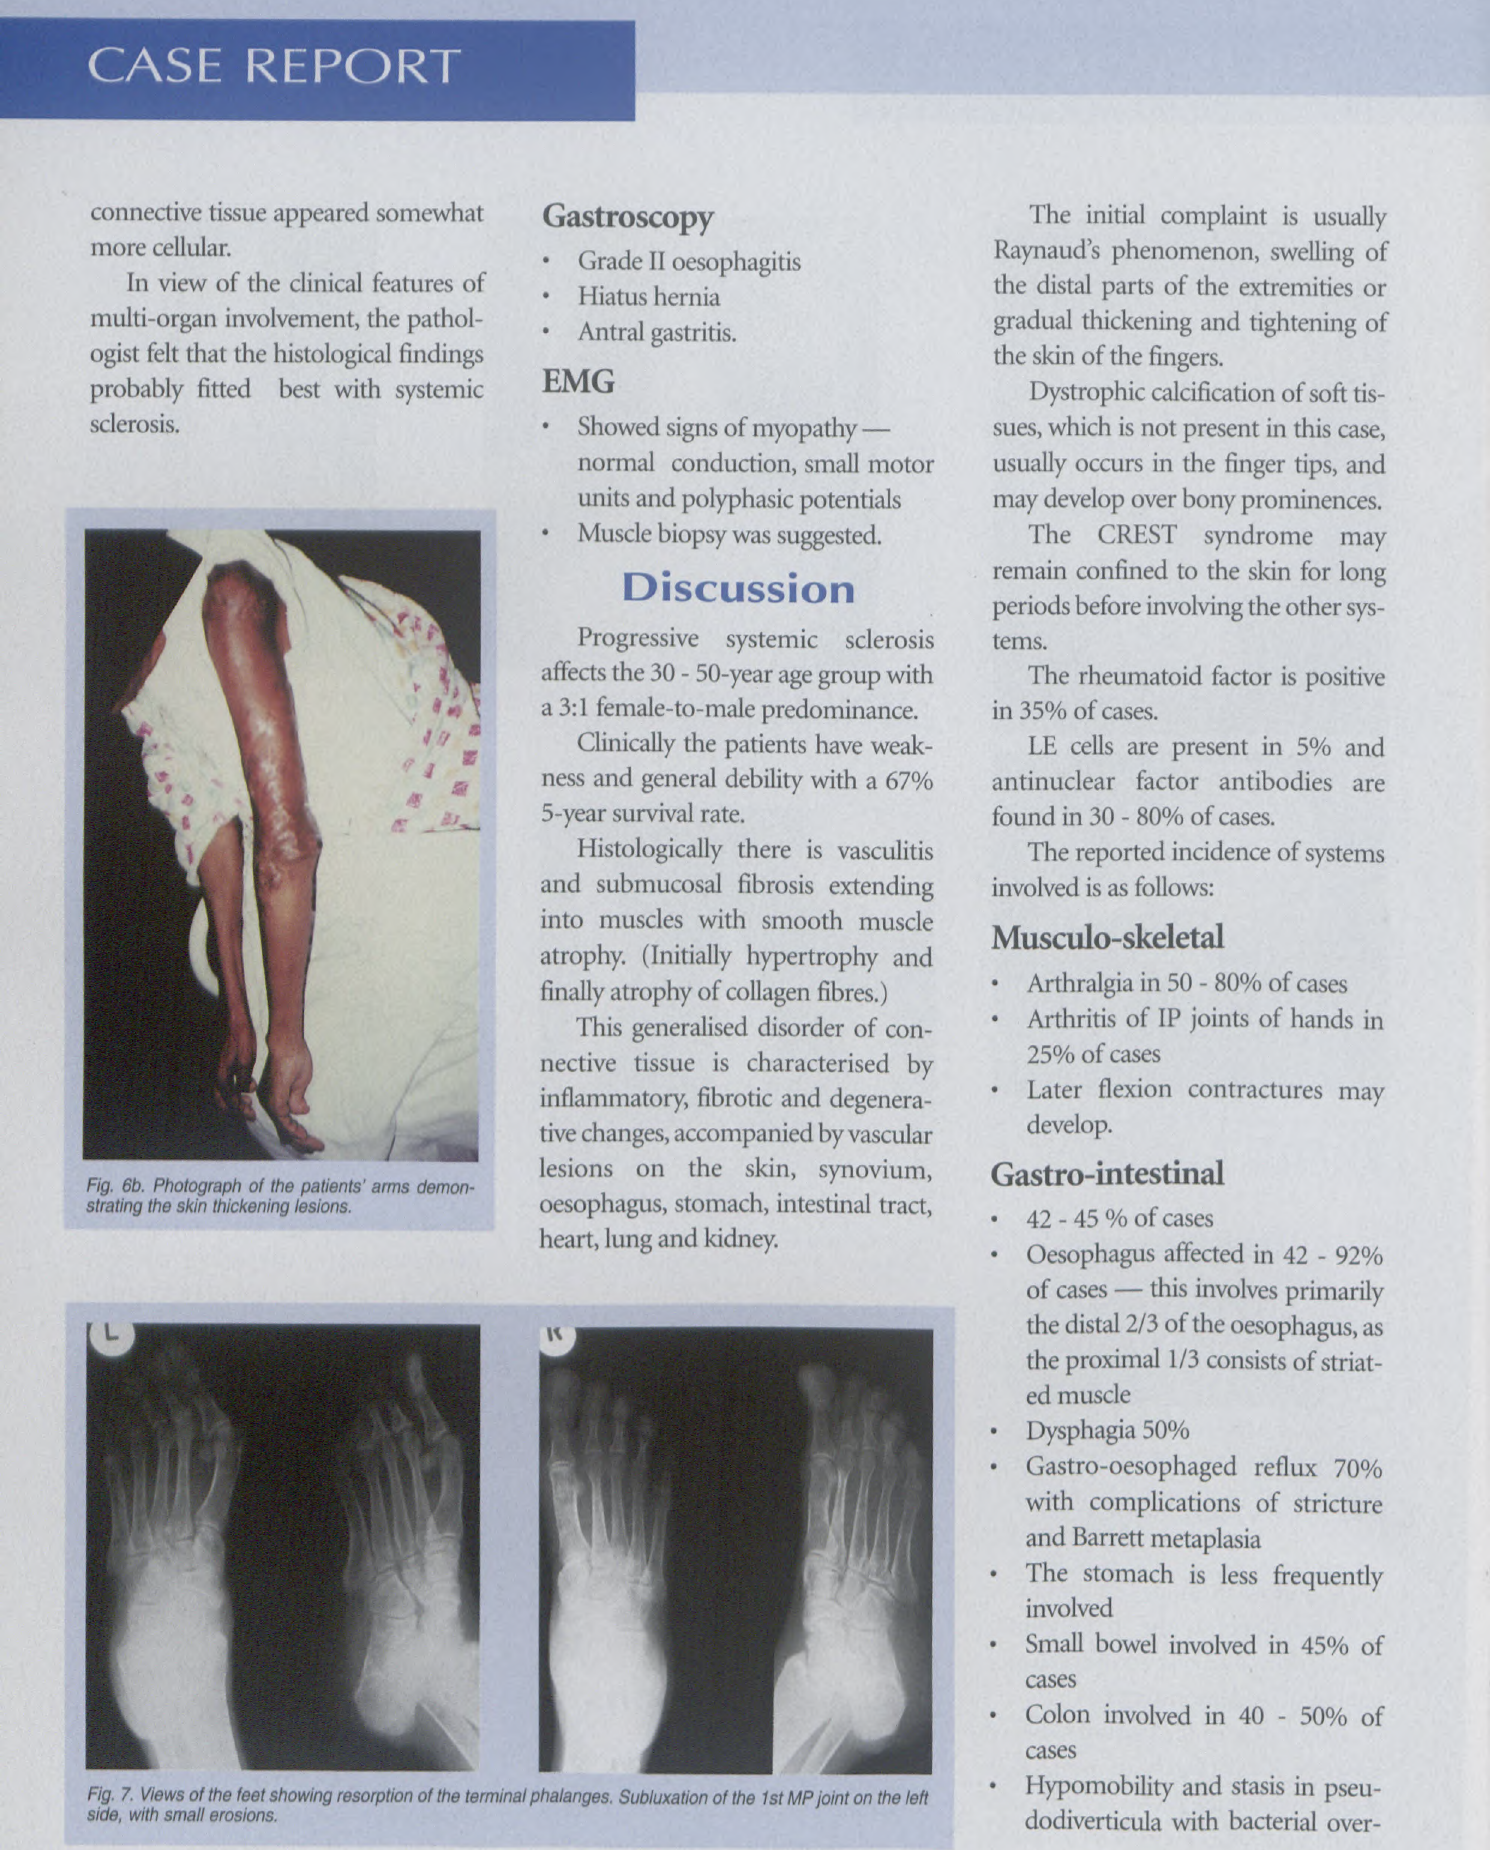
Fig. 7. Views of the feet showing resorption of the terminal phalanges. Subluxation of the 1st MP joint on the left side, with small